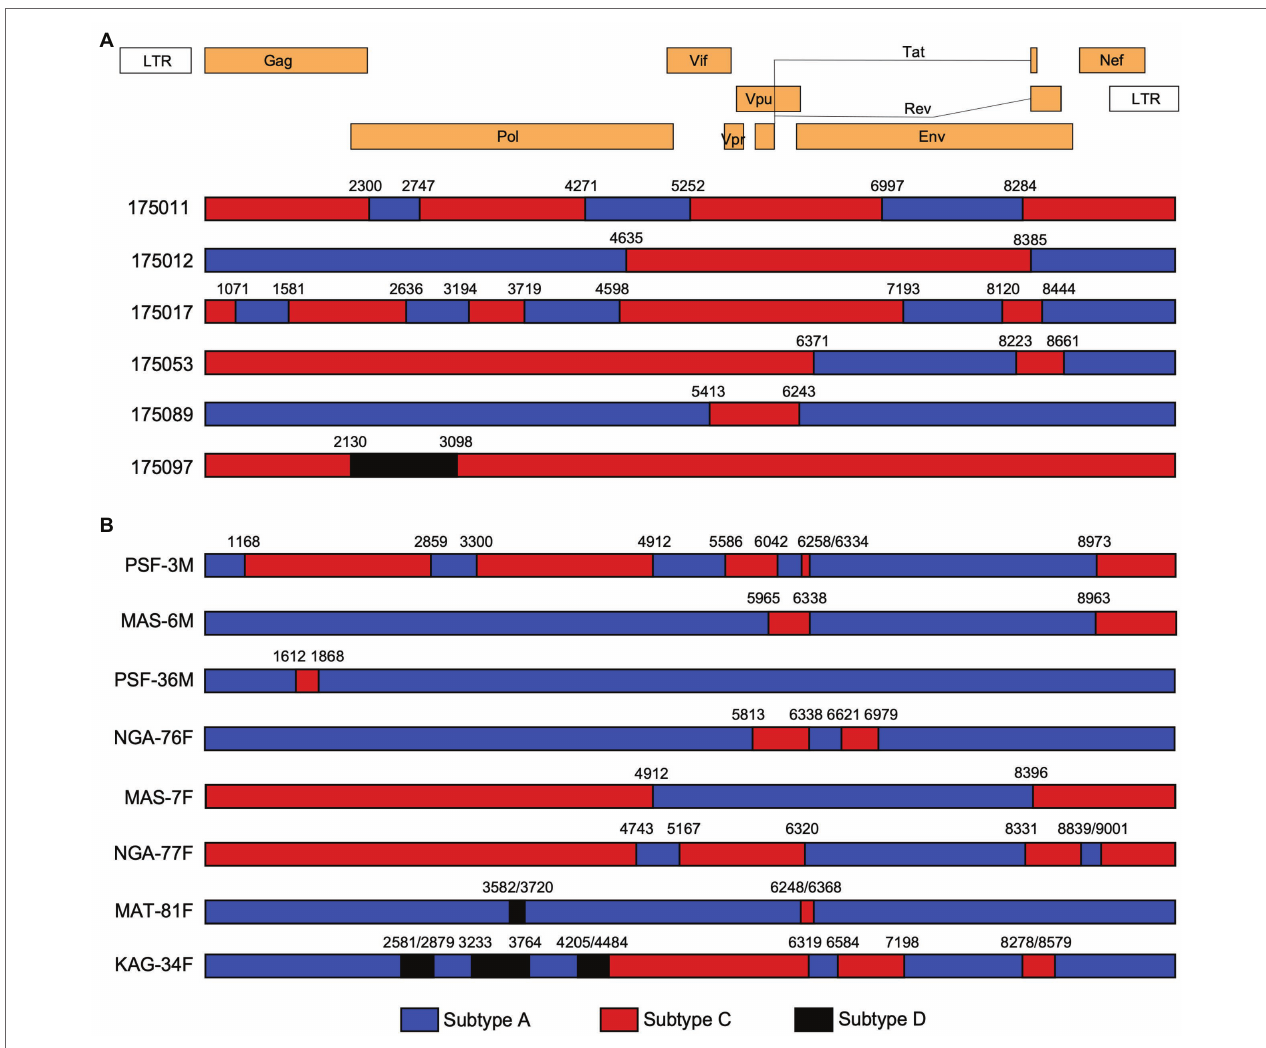
FIGURE 3 | Recombination analysis of Protocol C and recent infections. The positions of recombination cross-overs and the subtype origin of genomic regions are shown based on the jphMM analytical tool. Nucleotide positions refer to the equivlent positions on the HXB-2 HIV-1 genome. (A) The six unique recombinant forms (URFs) from the Protocol C acute infection cohort. (B) The recombination structure of recent Rwandan seroconvertor viruses. PSF-3M illustrates the identical recombinant structure found in all five early isolates from MSM (PSF-3M, -24M, -33M, -38M, and -39M). Subtype sequences are denoted by the same colors as in Figure 1